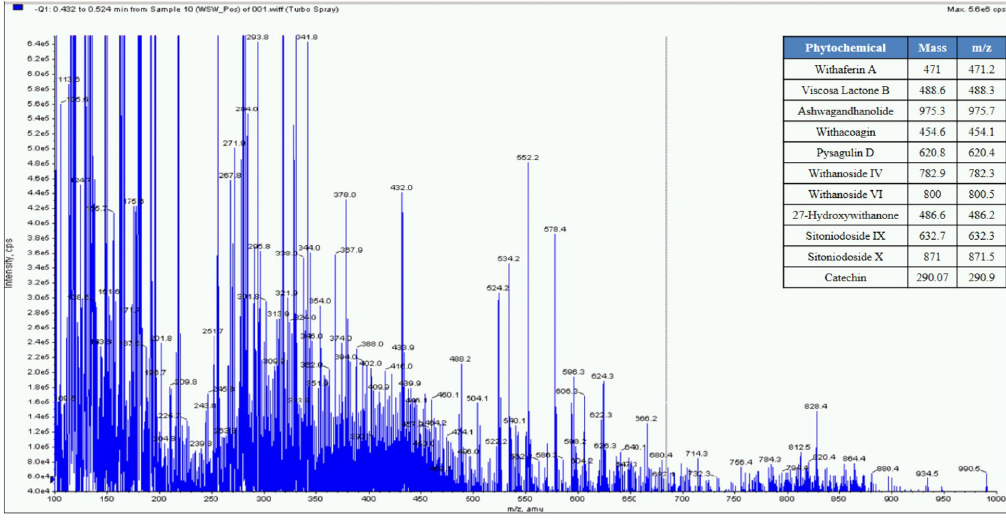
Fig 4. Mass spectrometer fingerprinting of Withania somnifera water extract (WSW).